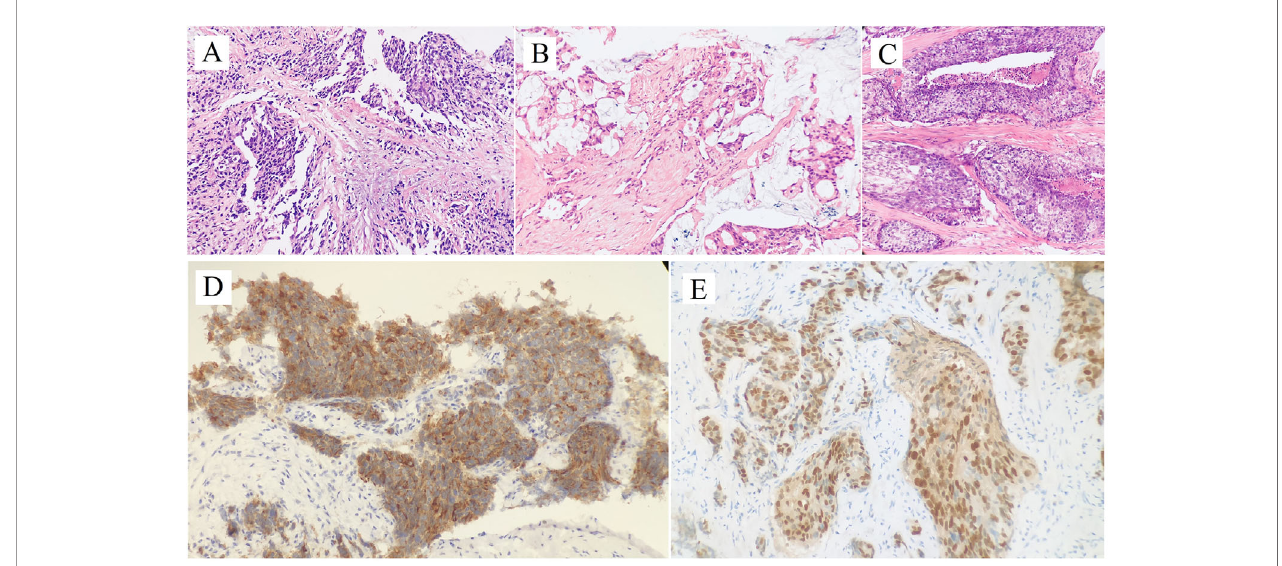
FIGURE 1 | Hematoxylin and Eosin staining of penile metastatic lesions showed poorly differentiated prostatic adenocarcinoma ( A : case 1; B : case 2; C : case 3). Two micrographs illustrate (D) PSA+, (E) NKX3.1+ tumor cells of the penile metastatic lesion in case